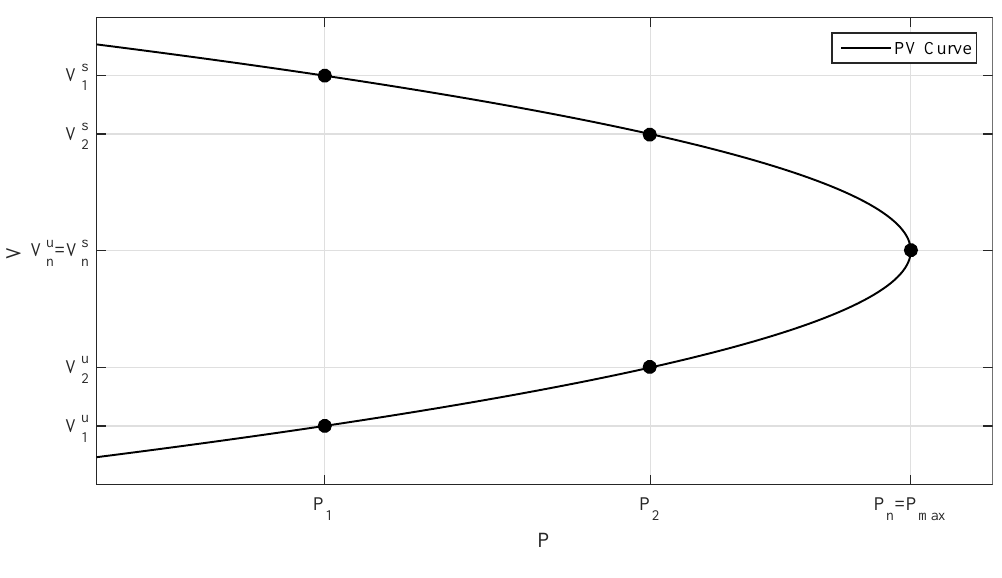
Figure 2. The PV